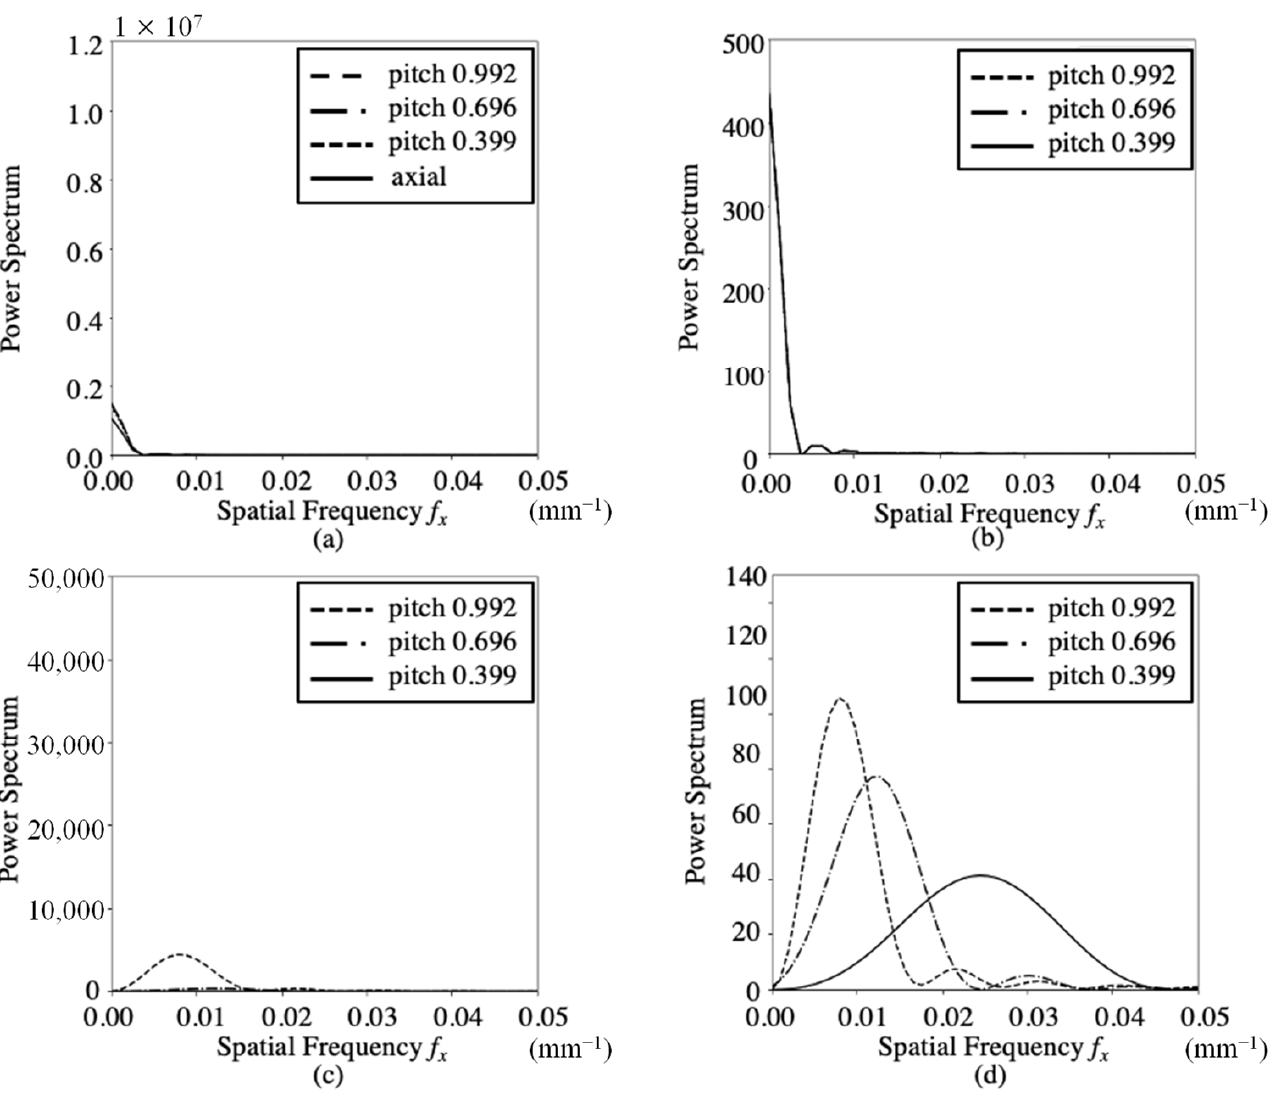
Figure 6. 2D and 3D spectra of Noise BL ( x , y ) and Noise VA ( x , y , z ) in IMR images for axial and helical scans. ( a ) 2D spectra of Noise BL ( x , y , z ) on the f x axis, ( b ) 2D normalized spectra of Noise BL ( x , y , z ) on the f x axis, ( c ) 3D spectra of Noise VA ( x , y , z ) on the f x axis, and ( d ) 3D normalized spectra of Noise VA ( x , y , z ) on the f x axis.